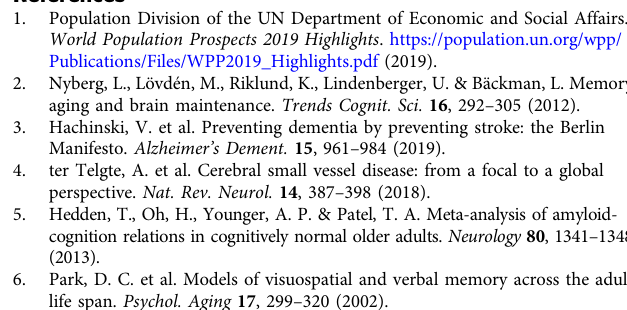
Table 2. Code for the sliding window analyses is available from